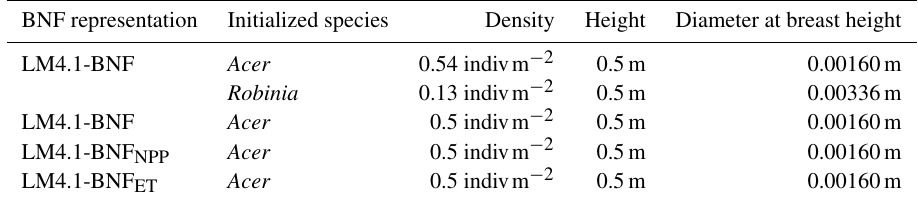
Table D4. Initial densities and heights for simulations. The initial densities of Robinia and Acer were derived from the US FIA database seedling data for plots with at least one Robinia individual in North Carolina. Diameter at breast height is determined from height by allometry (Eq. A41).